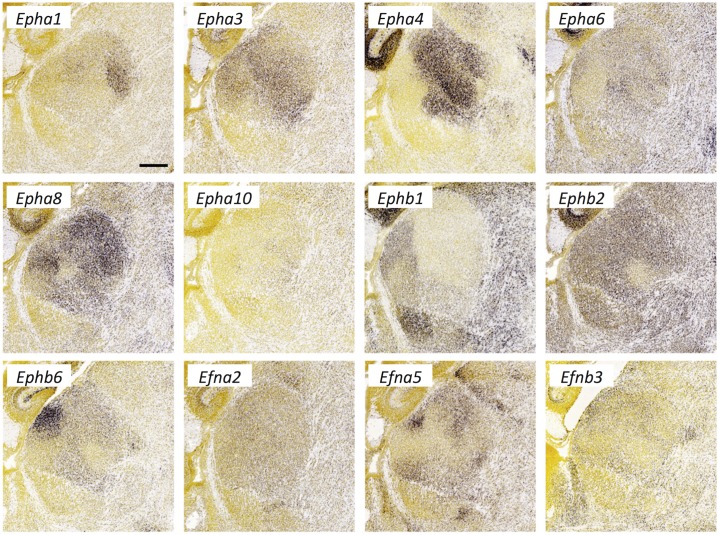
Ephrin and Eph-receptor expression in the thalamus at E18.5.In situ hybridization data from sagittal sections of the thalamus at E18.5 obtained from the devABA revealed differential patterns of expression of Eph-receptor (Eph) A1, A3, A4, A6, A8, A10, B1, B2, B6, and Ephrin (Efn) A2, A5 and B3. See text for details. A representative and equivalent section of medial thalamus is shown for each gene (see S8 Fig for details on how the sections were selected). Scale bar in EphA1: 317 μm.